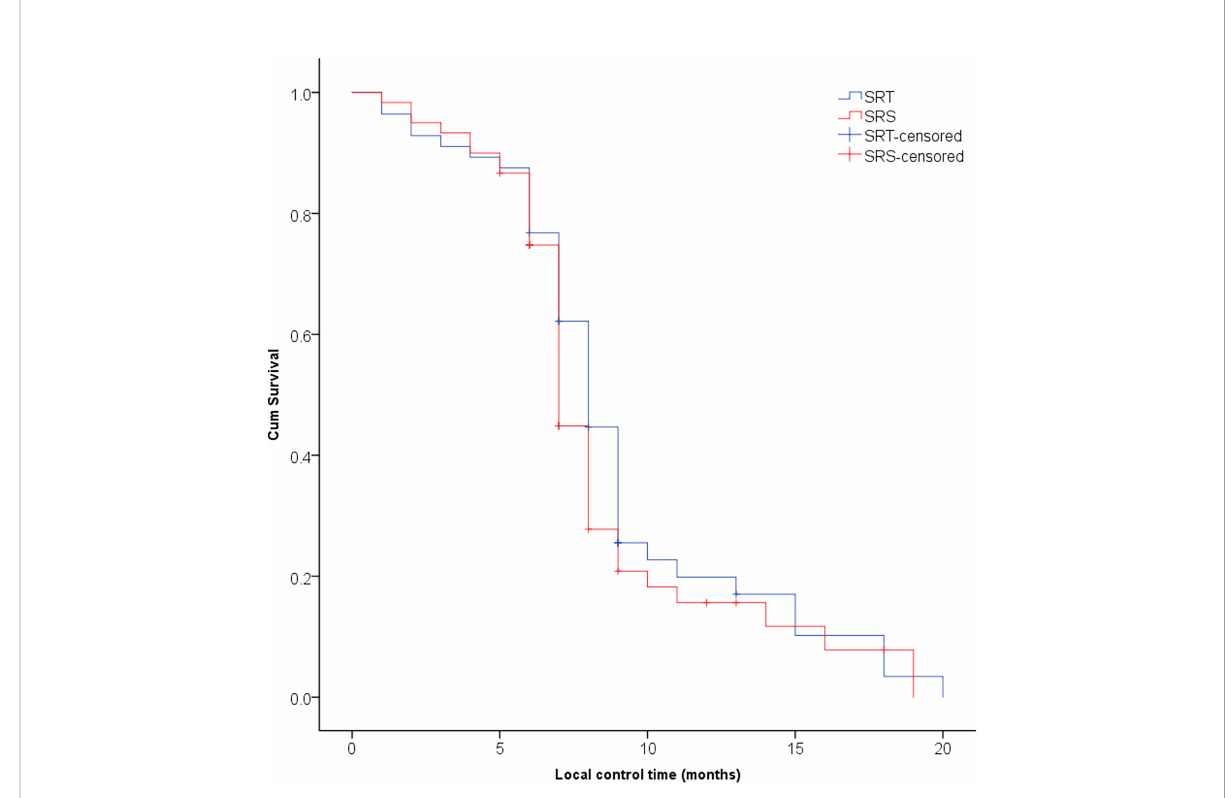
FIGURE 1 No signi fi cant difference was observed in the local control rate of brain metastases between the SRT and SRS groups (P =